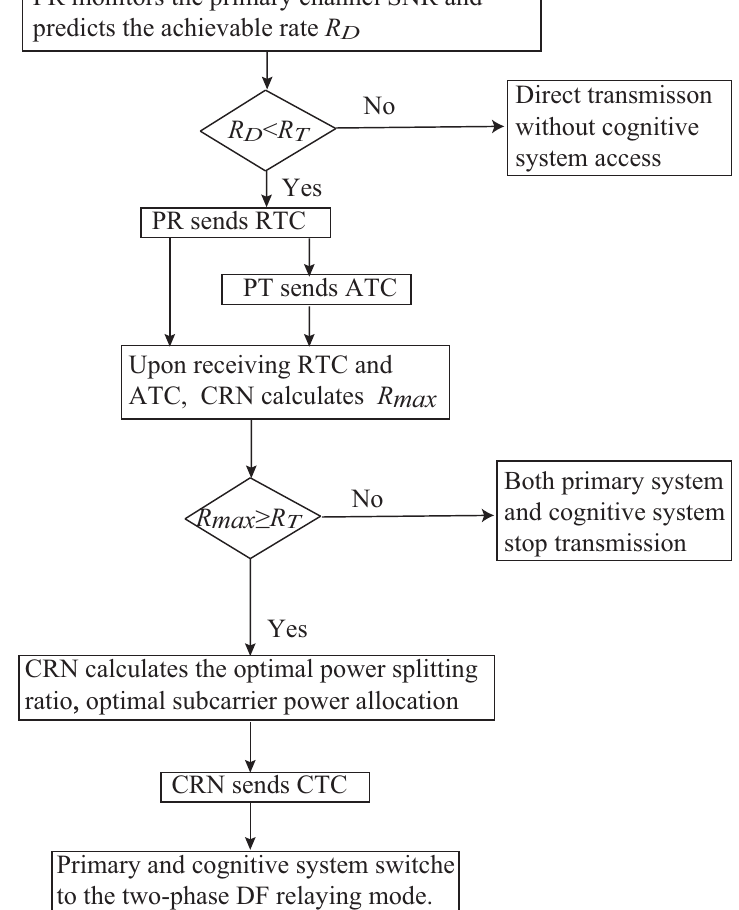
Figure 2. Flowchart of the proposed opportunistic spectrum sharing